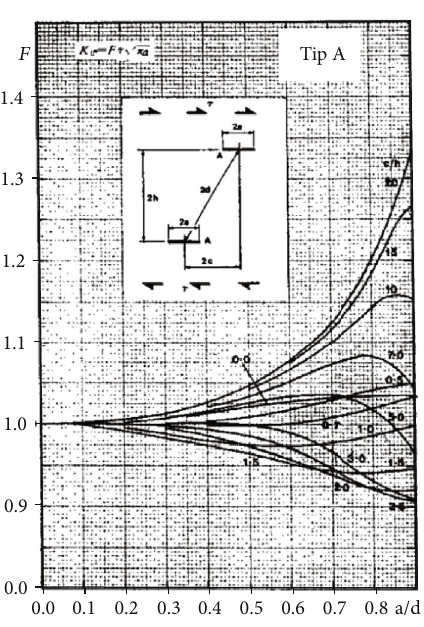
F C 3 ΙΙ and ΙΙ [22].